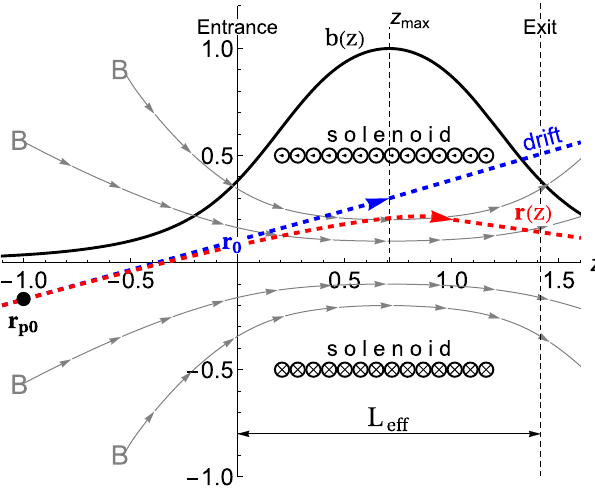
FIG. 1. Schematic of particle dynamics in magnetic field of solenoid. The blue dashed line represents an abstract drift of particle coming from z ¼ −∞ in the case of zero magnetic field [see Eq. (6)]. The red dashed curve represents particle orbit r ð z Þ in solenoidal magnetic field. The gray arrow lines represent the magnetic field distribution in the solenoid. The vertical axis represents relative scale for all of schematics listed